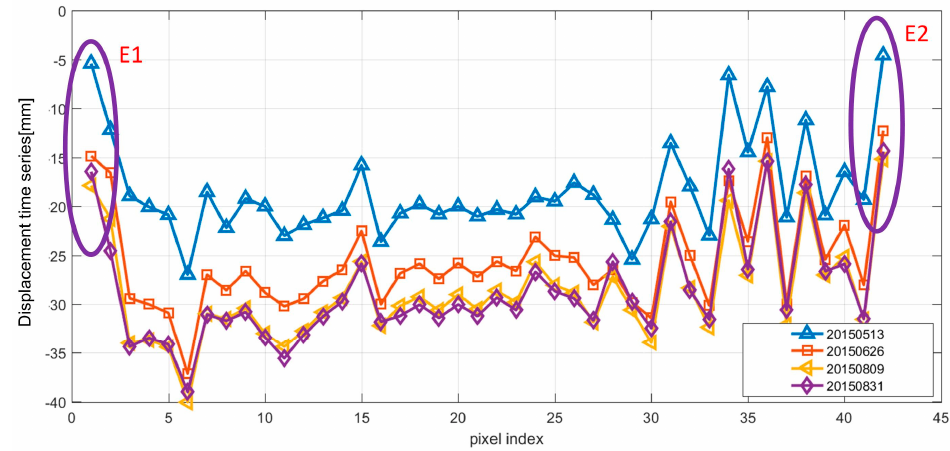
Figure 19. Longitudinal direction displacement analysis along E1E2 on Anlite Bridge.